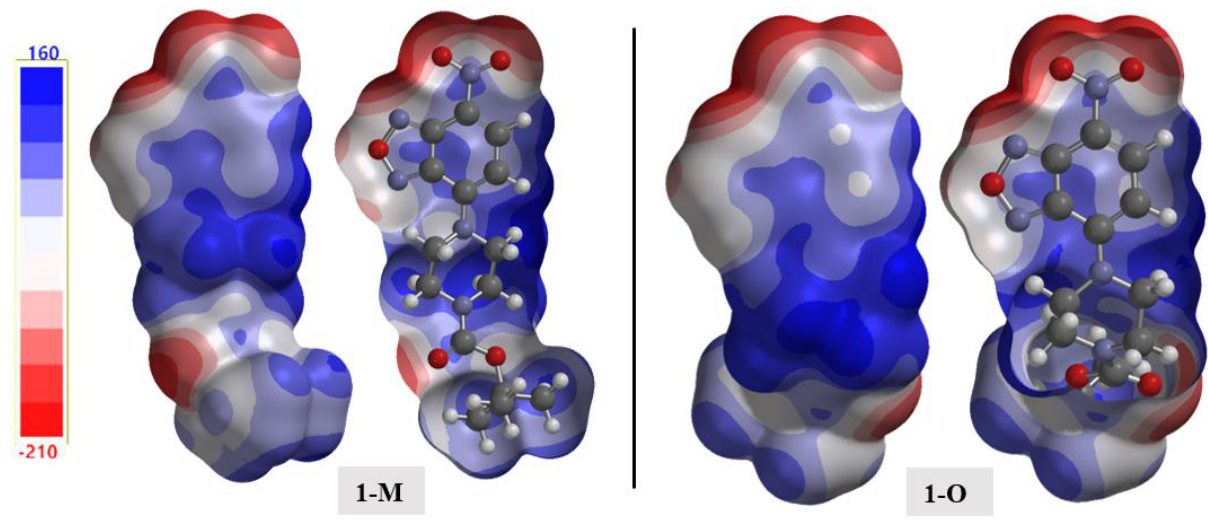
Figure 18. The calculated electrostatic potential maps for 1 - M and 1-O . A cutaway of the surface is shown for clarity.